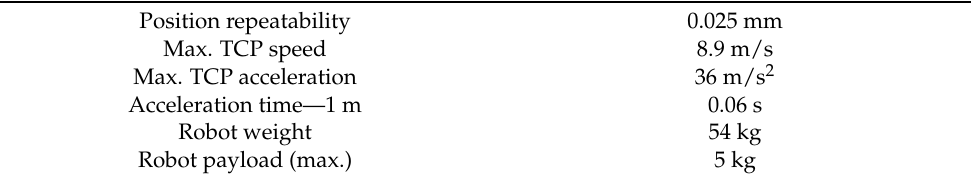
Table 1. Basic parameters of IRB1200 5/0.9 [26].